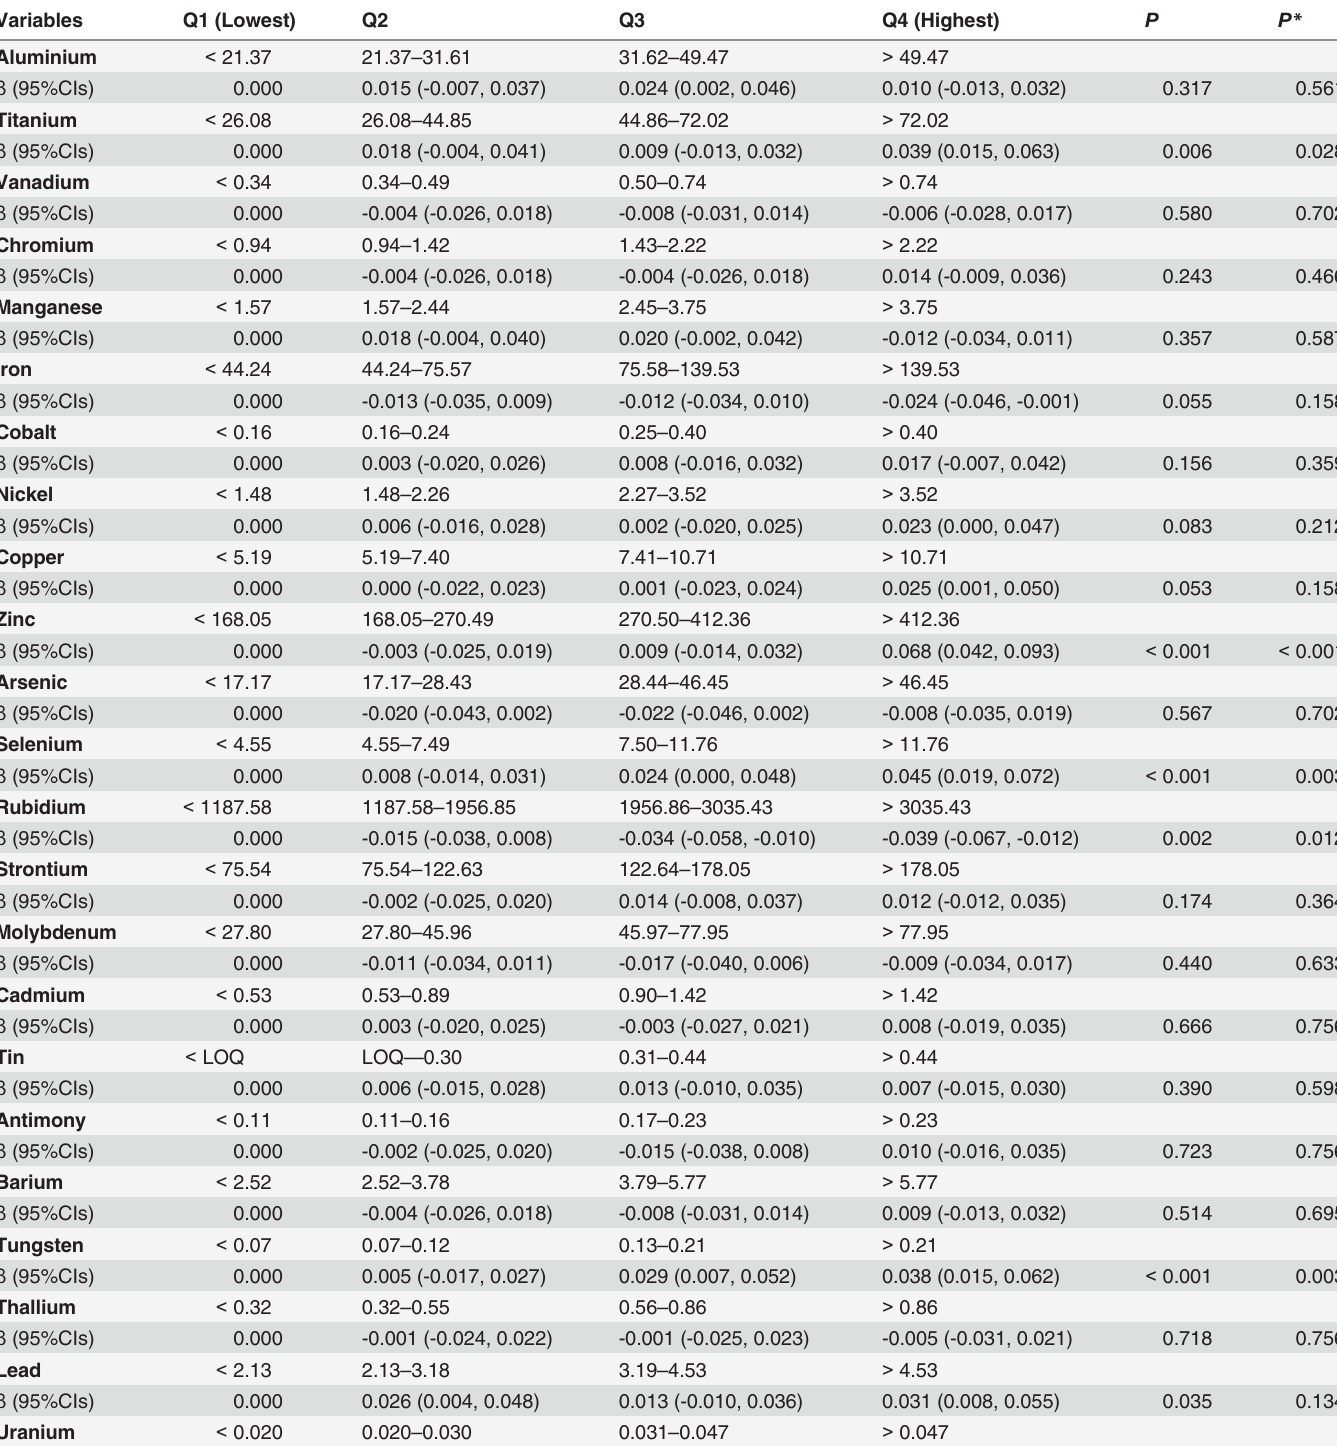
Table 2. Adjusted regression coefficients (95% CIs) for the association between quartiles of urinary metals and